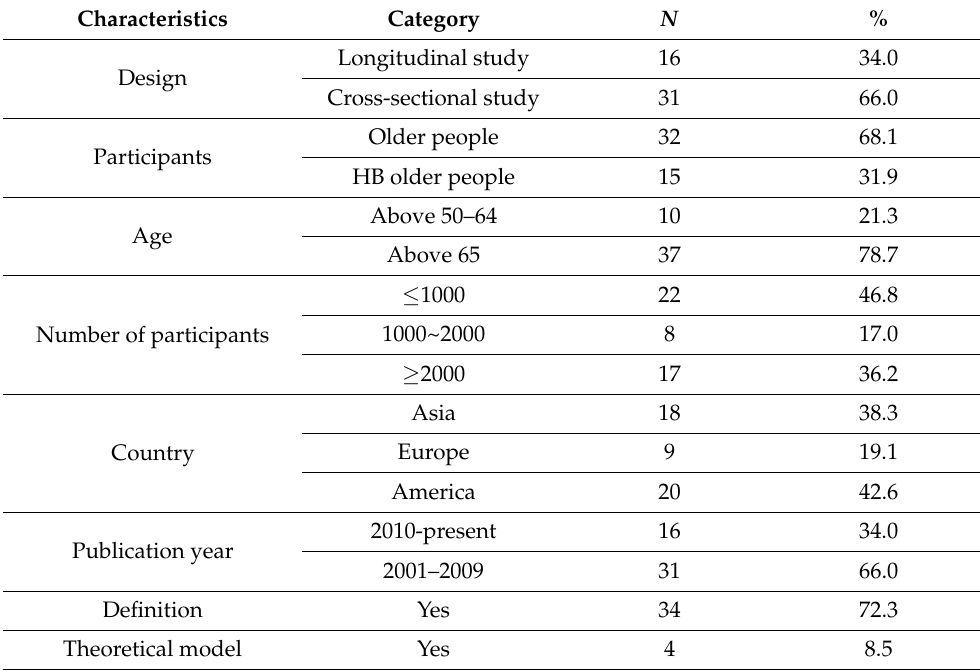
Table 2. General characteristics of previous studies regarding HB ( N =